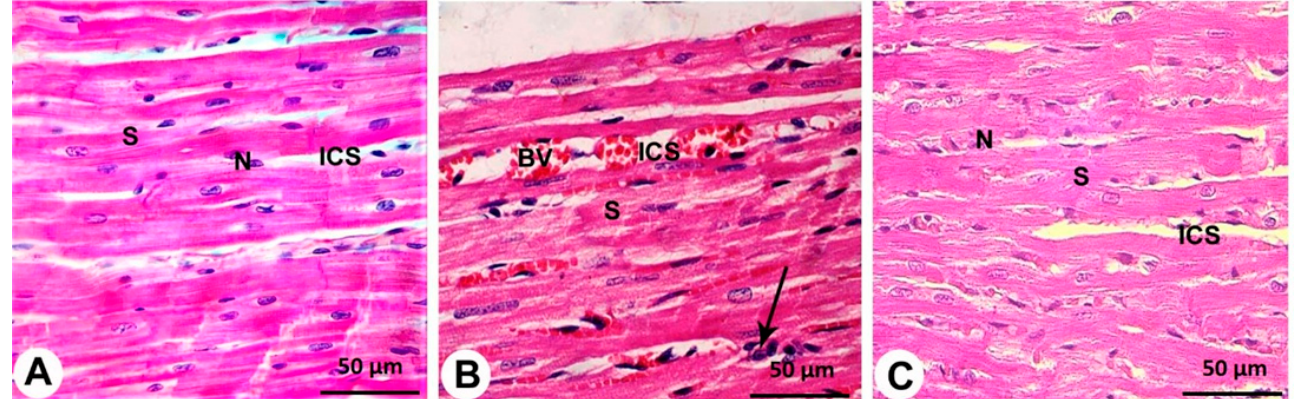
Figure 2. Histopathological evaluation of cardiac architecture from all groups (400 × ). The control group ( A ) shows centrally located nuclei (N), branching cytoplasmic network with striations (S) and delicate connective tissue between the muscle fibers (ICS) with few capillaries ( C ). The endotoxin group ( B ) shows more apparent alterations, where most of the cardiac muscle fiber striations (S) have disorganization and fragmentation, increment of nuclear peripheralization and pyknosis (N) together with sarcoplasmic vacuolation. Increased interstitial space (ICS) with congestion and dilation of the blood capillaries (BV) and monocellular infiltration (arrow) are displayed. Endotoxin plus Vit C treated group ( C ) shows the approximately normal histological appearance of cardiac myocyte striations (S), minimal interstitial space (ICS) and decreased congestion of blood capillaries. Some pyknotic nuclei (N) are still seen.